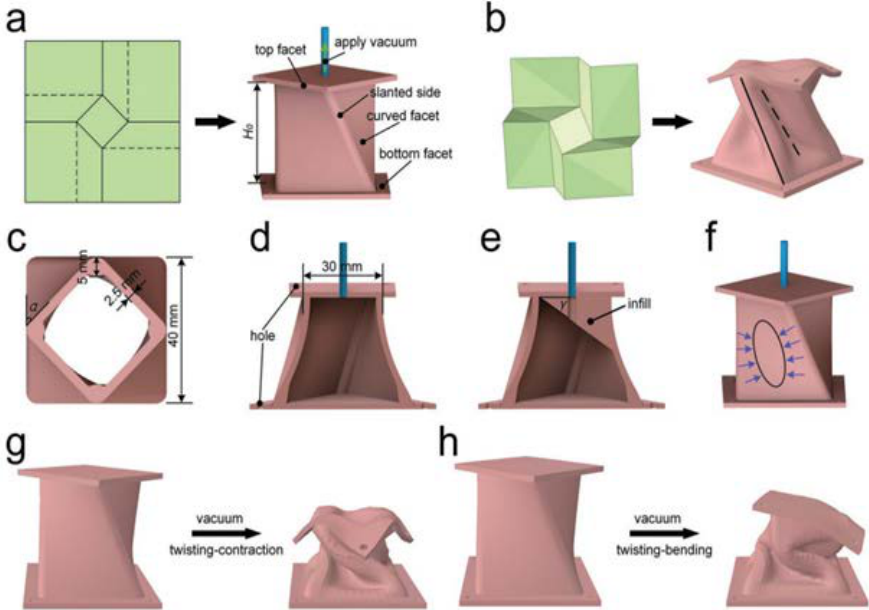
Figure 12. Origami-inspired vacuum actuator. Found in source [13]. ( a , b ) illustrate the origami inspiration for the vacuum actuators. ( c , d ) show the dimensions of the actuator. ( e ) shows the special change in design for the bending actuator. ( f ) illustrates the focal point of the buckling action, the blue arrows point toward the direction of the movement towards the focal point. ( g , h ) show the working action of the twisting-contracting and twisting-bending actuators, respectively (Reprinted with permission from Jiao, Z., et al. [13]. Copyright 2019, CC BY 4.0 International).